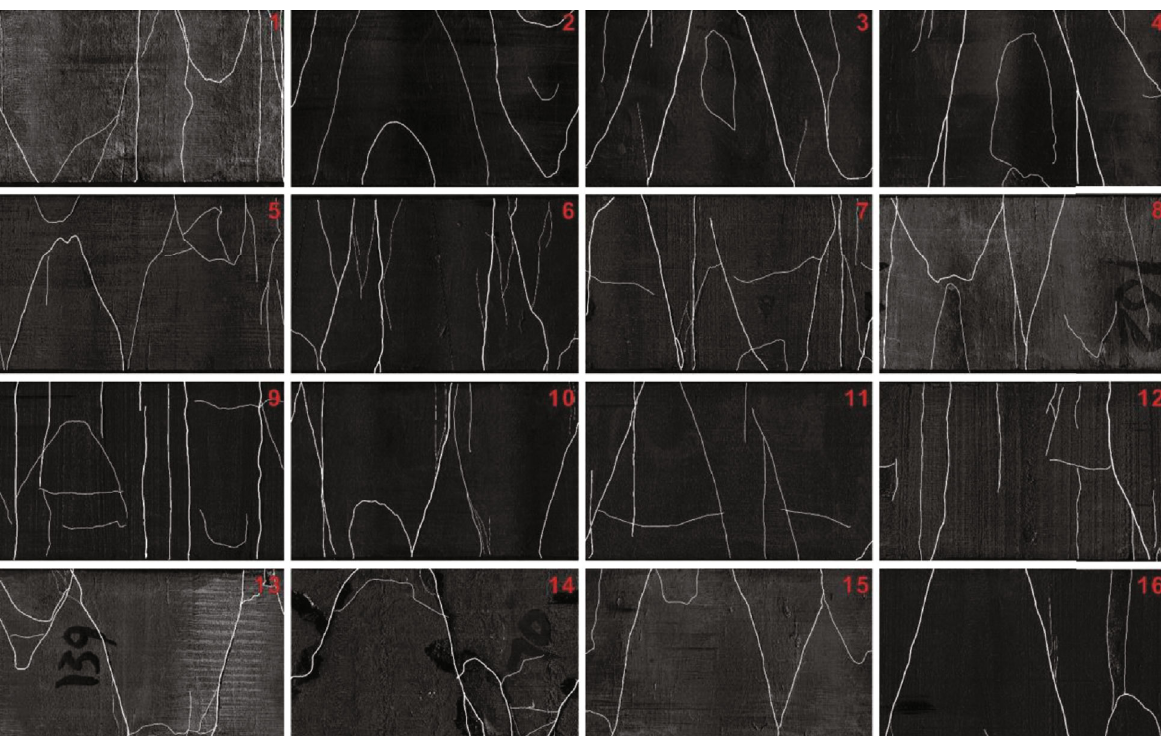
Figure 5: 2D fracture images of the pressed